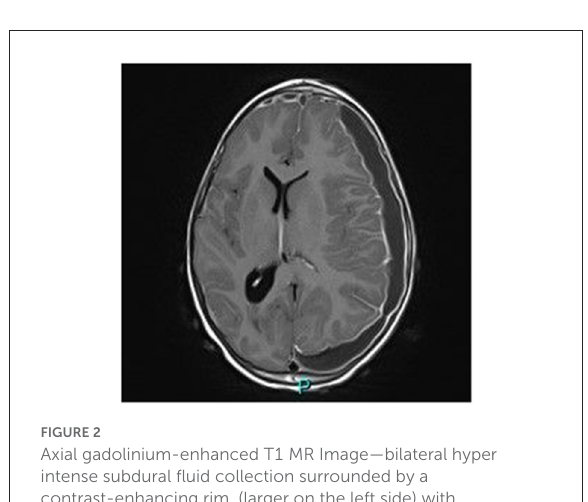
FIGURE2 Axial gadolinium-enhanced T1 MR Image—bilateral hyper intense subdural fluid collection surrounded by a contrast-enhancing rim. (larger on the left side) with left-to-right midline shift. Neither parenchymal involvement nor related cerebral oedema.